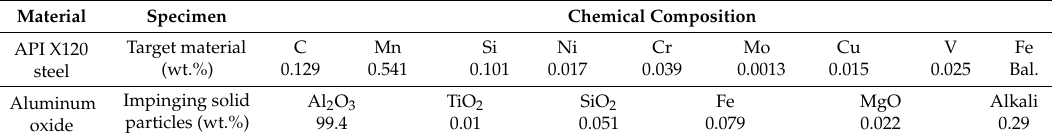
Table 1. Chemical composition of target steel (API X120) and impinging solid